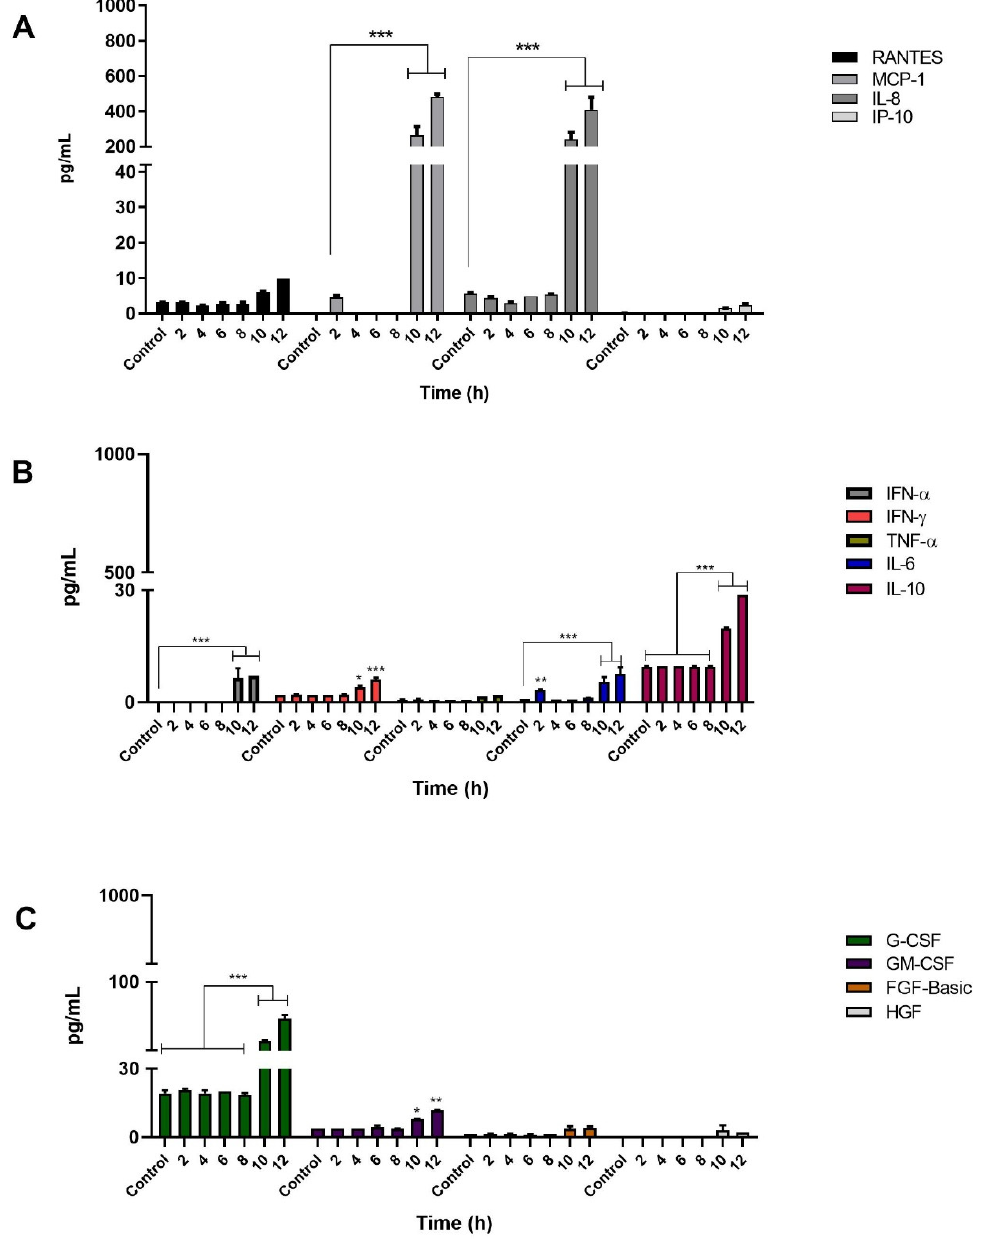
Figure 7. Cytokine production by keratinocytes (HaCaT) infected with S. schenckii yeast cells. Infection kinetics at 12 h, 1:1 MOI. Quantification of ( A ) chemokines, ( B ) cytokines and ( C ) growth factors was performed using LUMINEX technology on Magpix ® equipment following the instructions of the Cytokine Human Magnetic 30-Plex Panel for LuminexTM Platform (Thermo Fisher Scientific) kit. Data are presented as the mean ± standard deviation (SD) of two independent experiments. * p < 0.01, ** p < 0.001 and *** p < 0.0001.